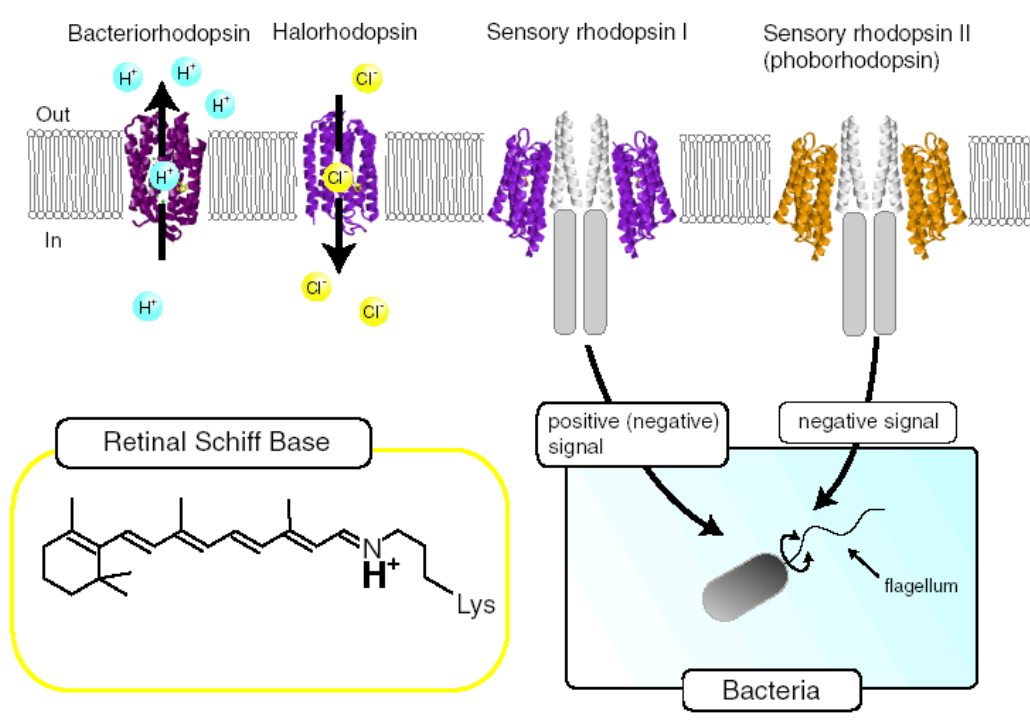
Figure 2. There are four archaeal rhodopsins in Halobacterium salinarum : bacteriorhodopsin, halorhodopsin, sensory rhodopsin I and II. All of them have seven transmembrane helices and an all- trans retinal as a